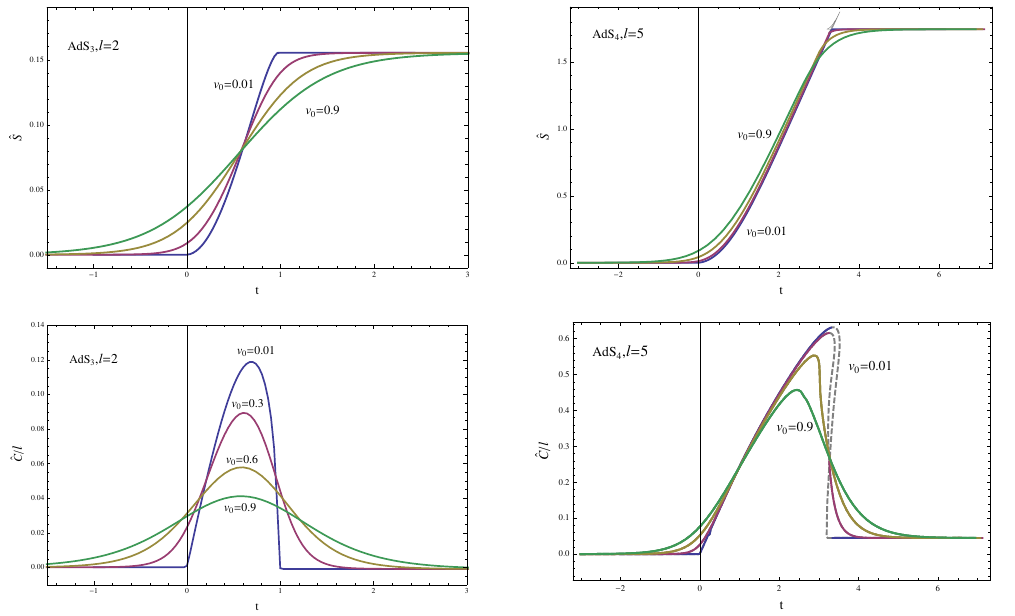
Figure 11 . The dependence of the entanglement entropy and the subregion complexity density ^ C=l on v 0 . We take v 0 = 0 : 01 ; 0 : 3 ; 0 : 6 ; 0 : 9 and (cid:12)x M = 1 here. The sudden drop in the subregion complexity evolution disappears when v 0 > 0 :